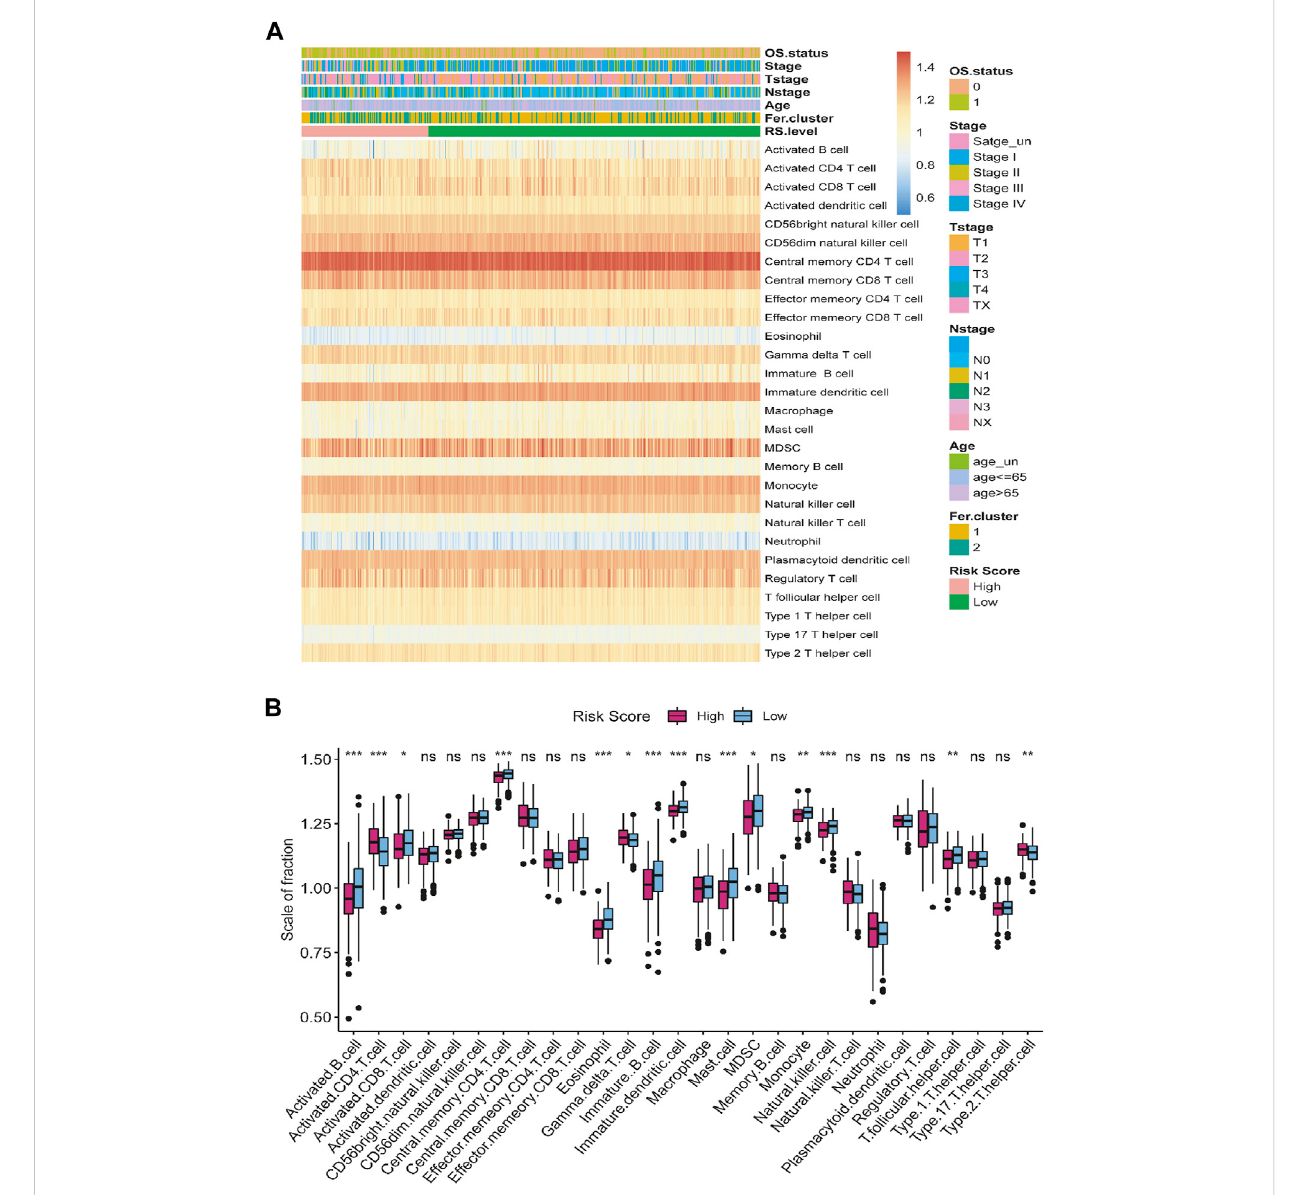
FIGURE 10 Therelationshipbetween tumorriskscore andimmune cellsin fi ltration. (A) Heatmapofthedistribution oftheimmune cellsin fi ltration. (B) Boxplot of the difference in immune cells in fi ltration between high- and low-risk score group. * p < 0.05, ** p < 0.01, *** p < 0.001, ns = no signi fi